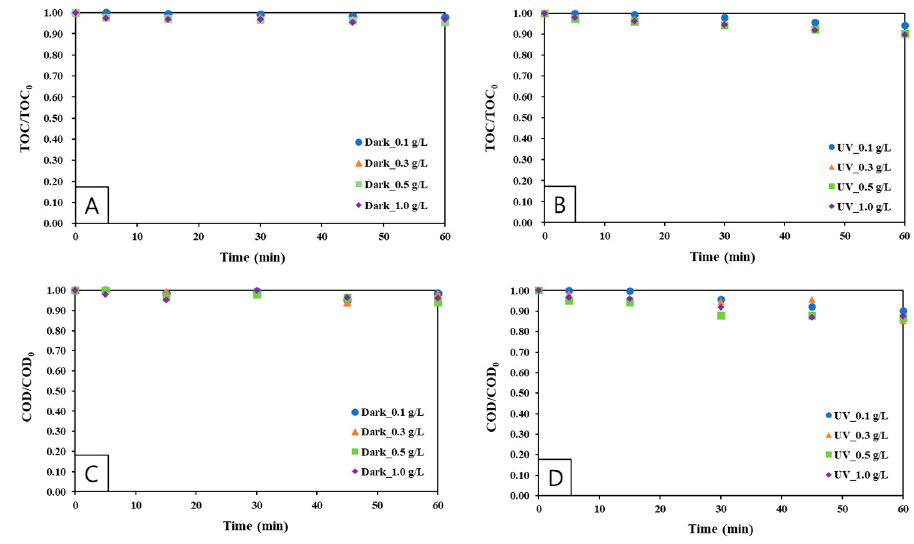
Figure 15. TOC removal under ( A ) dark conditions and ( B ) UV illumination, and COD removal under ( C ) dark conditions and ( D ) UV illumination.